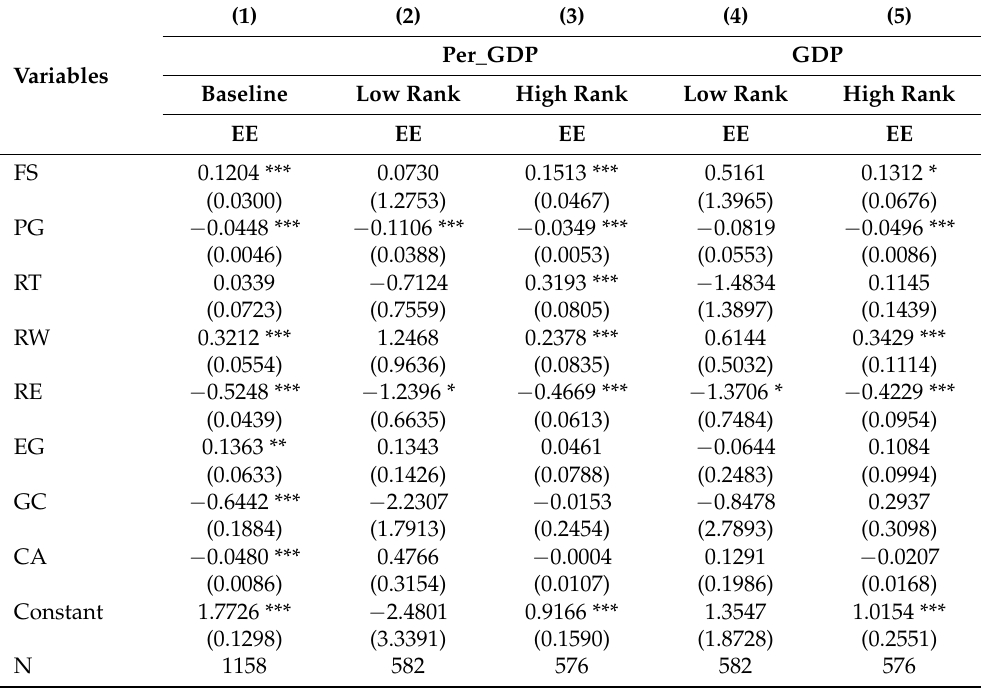
Table 8. Empirical analysis of economic development heterogeneity